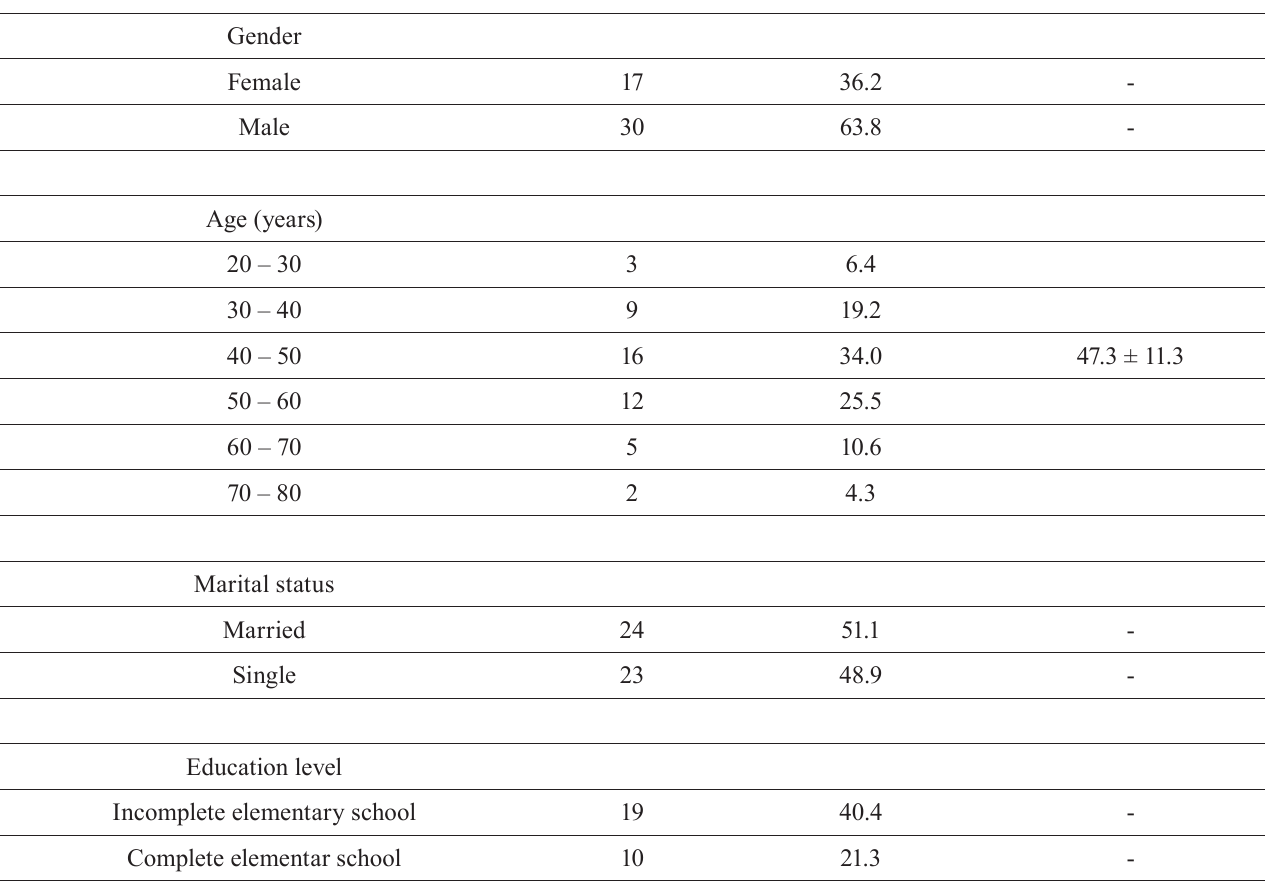
TABLE I - S ociodemographic characteristics of participants in the HBQOL validation in the city of Curitiba – PR